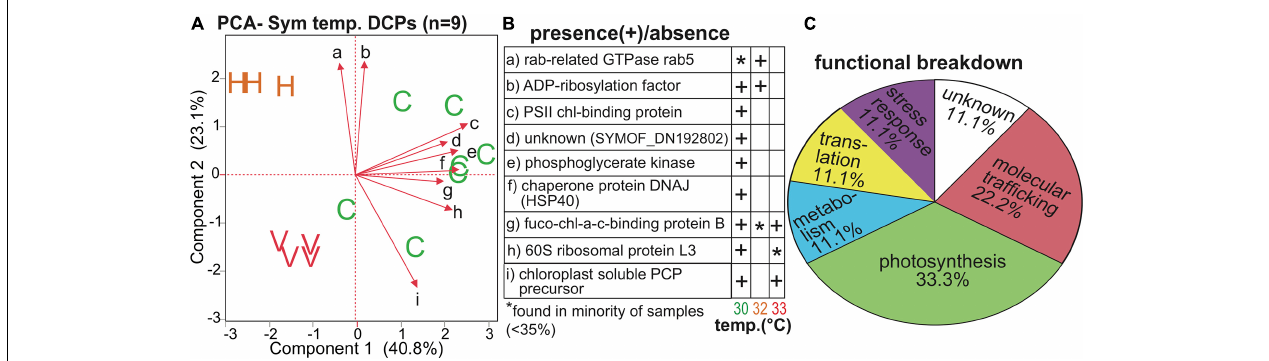
FIGURE 5 | Temperature-sensitive Symbiodiniaceae proteins. A PCA with the nine proteins whose concentrations differed significantly across temperatures (A) in which “C,” “H,” and “V” correspond to c ontrol (30 ◦ C), h igh (32 ◦ C), and v ery high (33 ◦ C) temperatures, respectively. The black, small-font, lower-case letters adjacent to the biplot rays correspond to the row where the respective data for each protein have been displayed in (B) . A functional breakdown of these proteins is depicted in (C) . chl = chlorophyll. Fuco-chl-a-c binding = fucoxanthin-chl-a-c binding protein B. PCP = peridinin chl-a-binding protein. PS = photosystem II. For details on these nine proteins, please see Table 4 and Supplementary Tables 3, 5 .